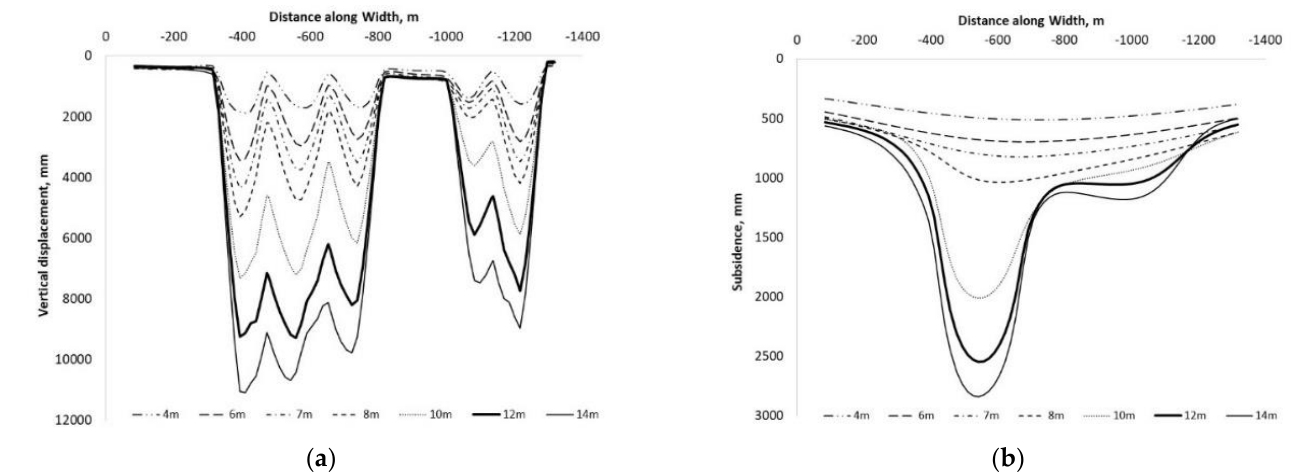
Figure 9. The influence of extraction thickness on overburden movement: ( a ) 11 m above the mining seam; ( b ) ground surface.